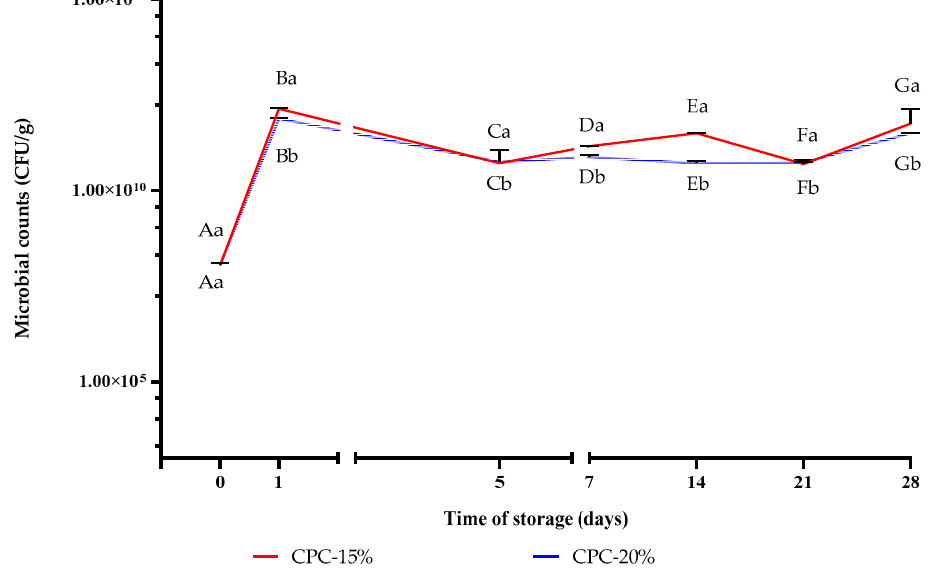
Figure 1. Lactic acid bacteria (LAB) counts during storage time.